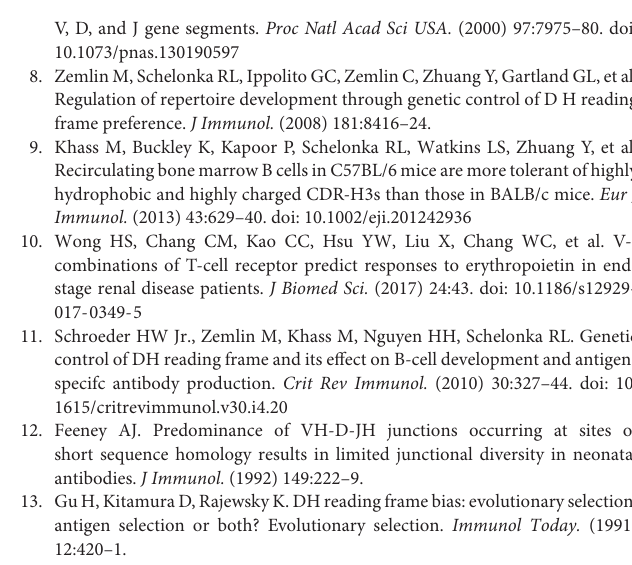
TABLE S1 | TCR CDR-B3 sequences. TABLE S2 | Germline V, D, and J CDR3 contributing sequences pertinent to this